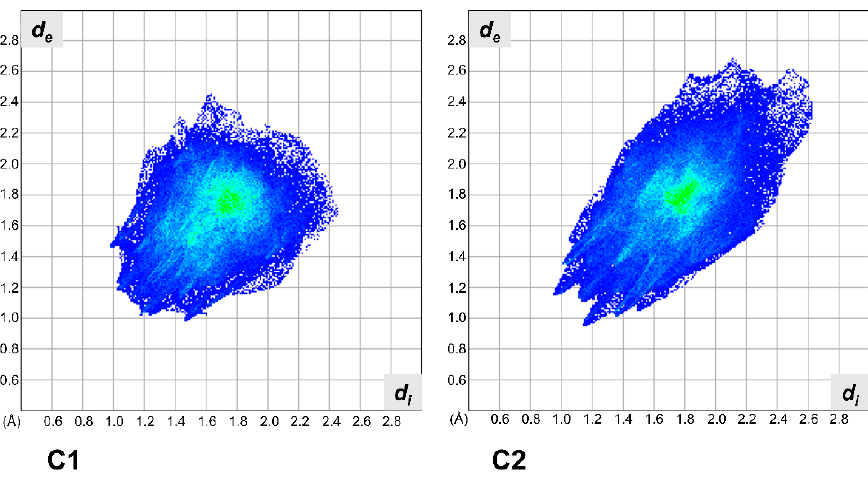
Figure 9. Hirshfeld fingerprint plots for C1 ( left ) and C2 ( right ).